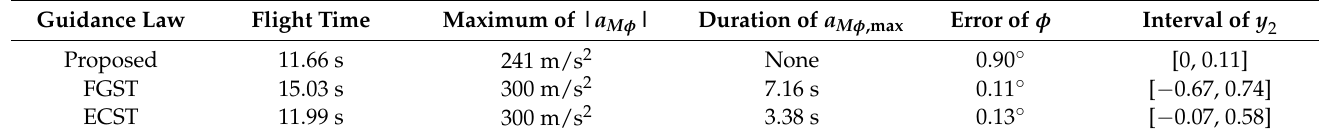
Table 3. Simulation results of case